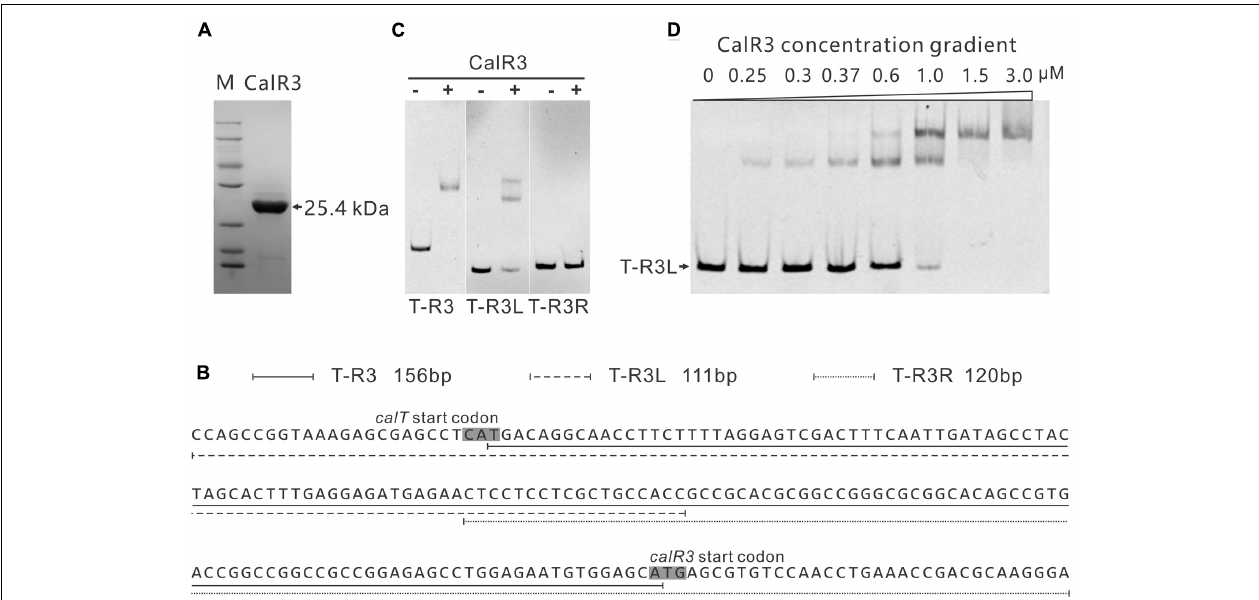
FIGURE 4 | Electrophoretic mobility shift assay (EMSA) analysis of CalR3 protein binding to target promoter regions. (A) SDS-PAGE analysis of CalR3, the theoretical molecular mass of His 6 -tagged CalR3 is 25.4 kDa. (B) Nucleotide sequences and relative location of probe T-R3, T-R3L, and T-R3R. (C) EMSAs of the interaction of probes T-R3, T-R3L, and T-R3R with 0.8 µ M of purified His 6 -CalR3 protein. (D) EMSAs of the interaction of probe T-R3L with concentration gradient His 6 -CalR3 protein.